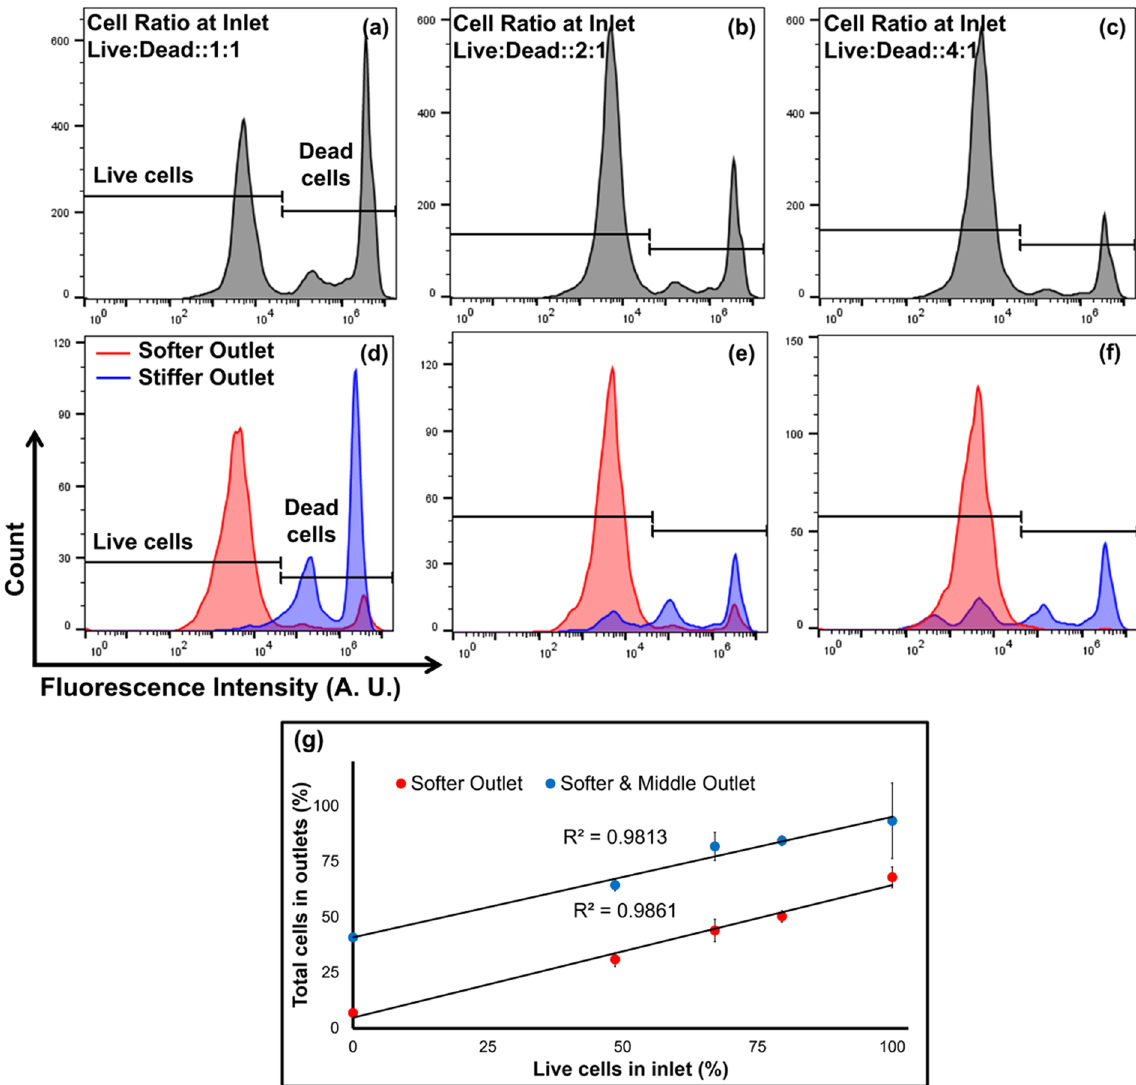
Figure 4. The flow cytometry results for different ratios of cells in the inlet; approximate ratio of live and dead cells in inlet ( a ) 1:1; ( b ) 2:1; ( c ) 4:1; the data obtained from softer and stiffer outlets for the ratio of live and dead cells at inlet ( d ) 1:1; ( e ) 2:1; ( f ) 4:1; ( g ) percentage of live cells in softer outlet for different percentage of live cells in inlet. For ( a – f ), x and y -axis are representing fluorescence intensity and cell counts, respectively.